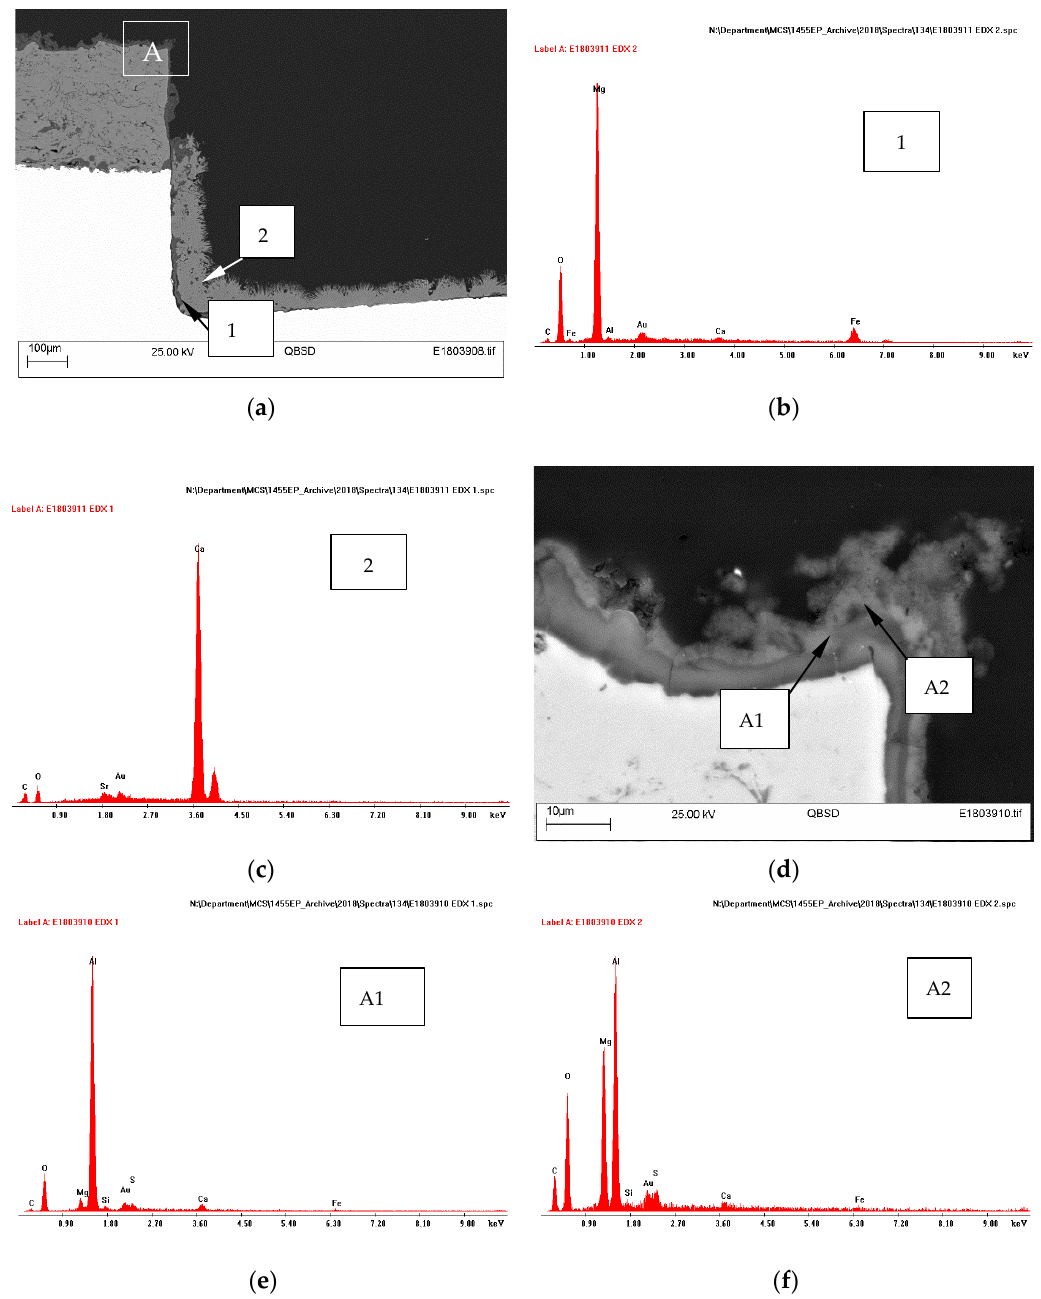
Figure 5. SEM micrographs of the cross-section of TSA specimen with one holiday (18.3% area) ( a ), ( d ); showing EDX patterns of regions 1 ( b ), 2 ( c ) and A1 ( e ) and A2 ( f ).